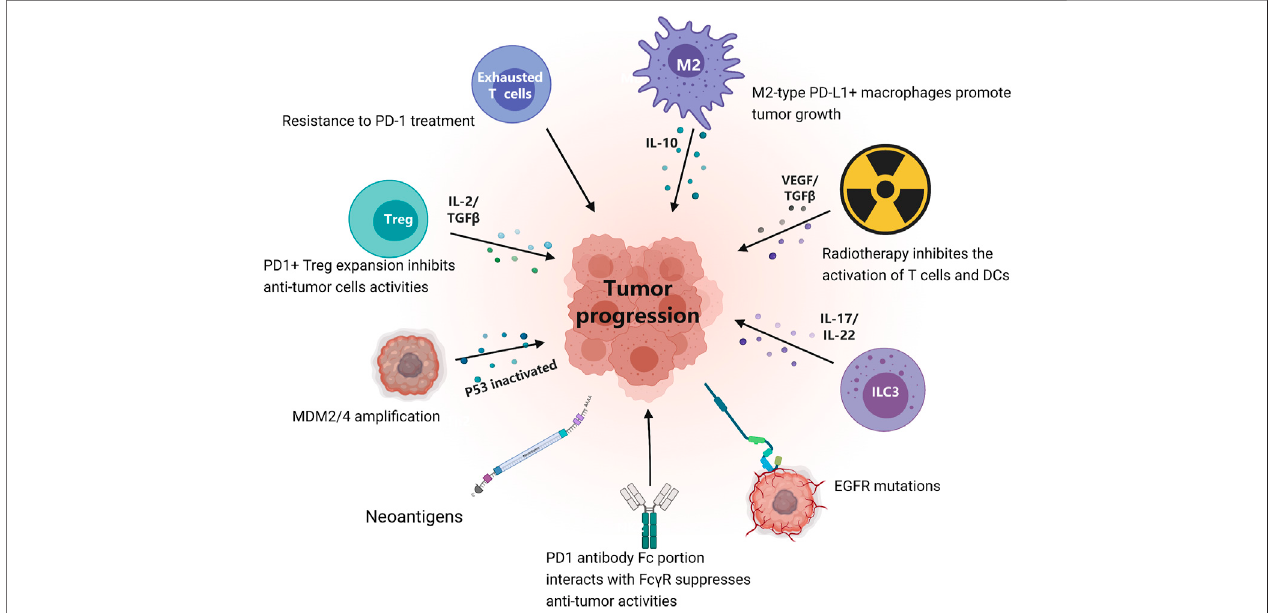
FIGURE 2 | Potential mechanisms of HPD under immune checkpoint inhibitor